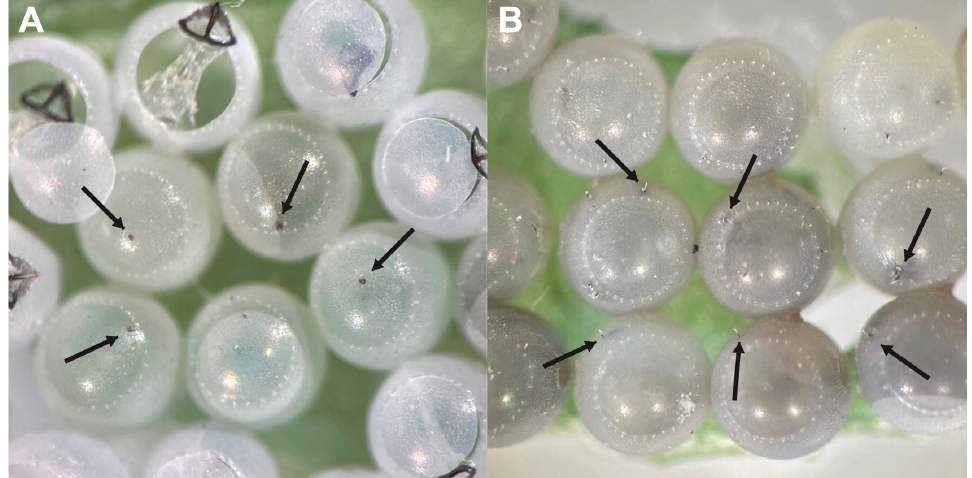
Figure 4. Halyomorpha halys eggs parasitized by Anastatus bifasciatus ( A ) and Ooencyrtus telenomicida ( B ). Arrows are pointing to oviposition sites of parasitoids.